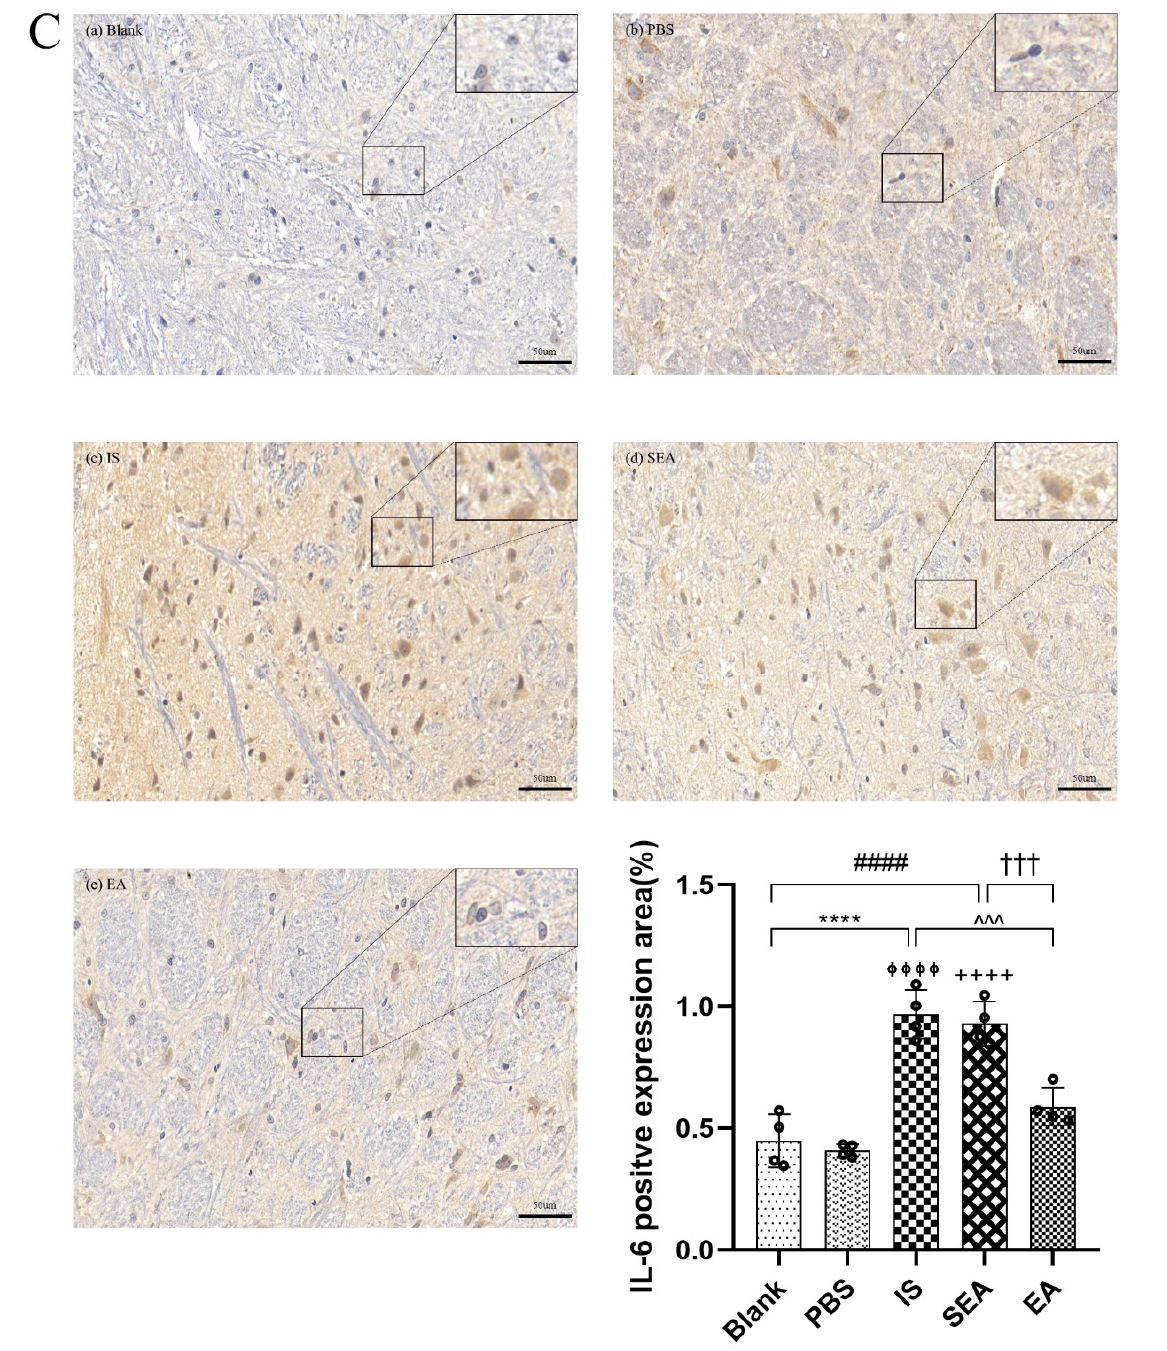
Figure 5. The positive expressions of inflammatory cytokines, including IL-1 β ( A ), TNF- α ( B ), and IL-6 ( C ), in TNC in five groups of rats (( a ): Blank; ( b ): PBS; ( c ): IS; ( d ): SEA; ( e ): EA) and the percentage of positively expressed area in the total observed area (area%) ( n = 4/group). Images of inflammatory cytokines’ IHC staining in TNC (400 × , Scale bar = 50 µ m, three sections/rat). Repeated IS infusions into dura induced an increased number of positive cells, while EA reduced positive expressions of those inflammatory cytokines. ANOVA and Tukey’s post hoc analysis test were performed and data are presented as the mean ± standard deviation. **** p < 0.0001, Blank vs. IS; ⏀⏀⏀⏀ p < 0.0001, PBS vs. IS; #### p < 0.0001, Blank vs. SEA; ++++ p < 0.0001, PBS vs. SEA; ^^^ p <